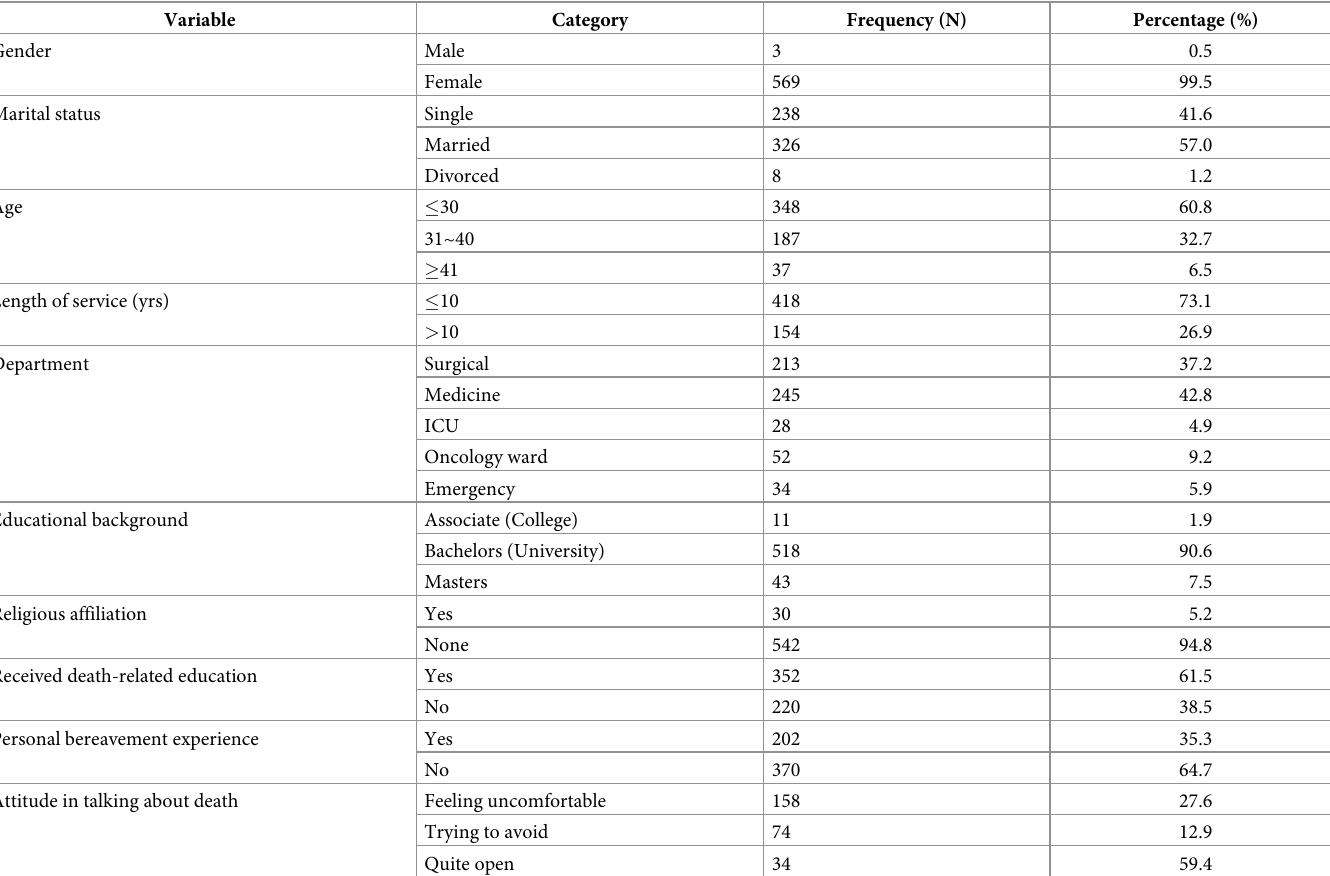
Table 1. Characteristics of participants (N = 572).